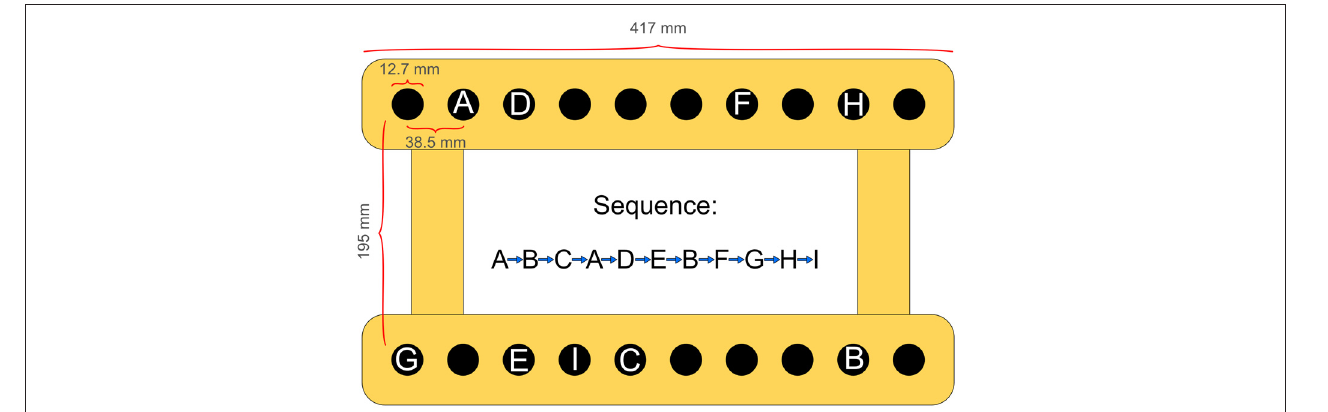
FIGURE 1 | Experimental apparatus and spatial locations to be reached for one after the other, defining the 10-element arm movement sequence .